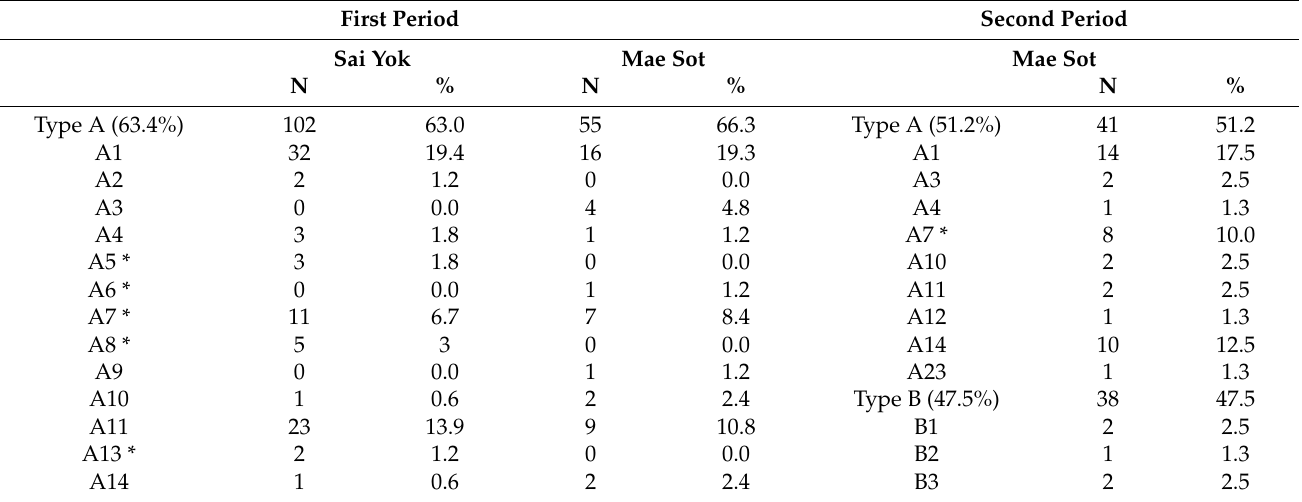
Figure 3. PCR product size variations and allelic variants of PvMSP-3 β . Gel images depict: ( A ) PCR product size variations, and ( B ) allelic variants for types A, B, and C. M: Molecular markers (100 bp and 1000 bp). M1 and M2: Mixed genotypes. Table 3. The proportion of PvMSP-3 β from the first (2006–2007) and second (2014–2016)